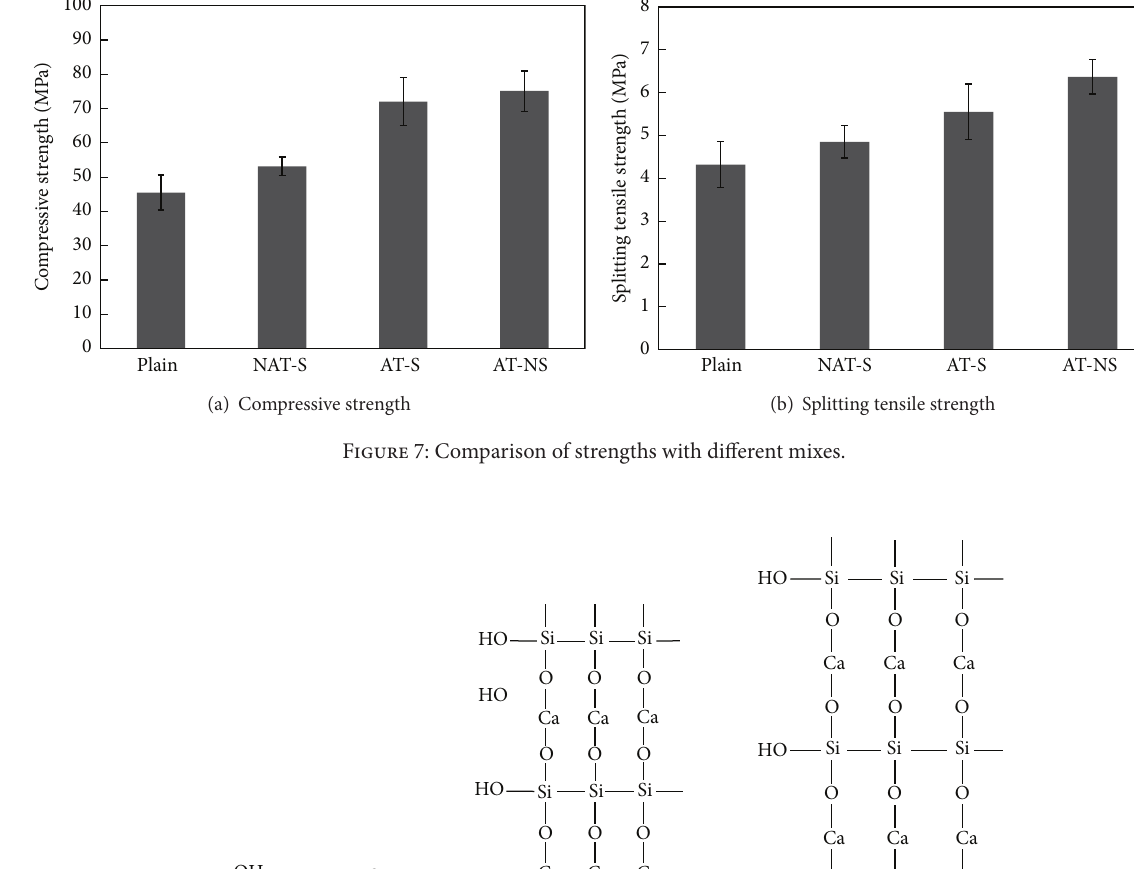
entrained air. The use of high-performance superplasticizer in acid-treated CNT increases the amount of entrained